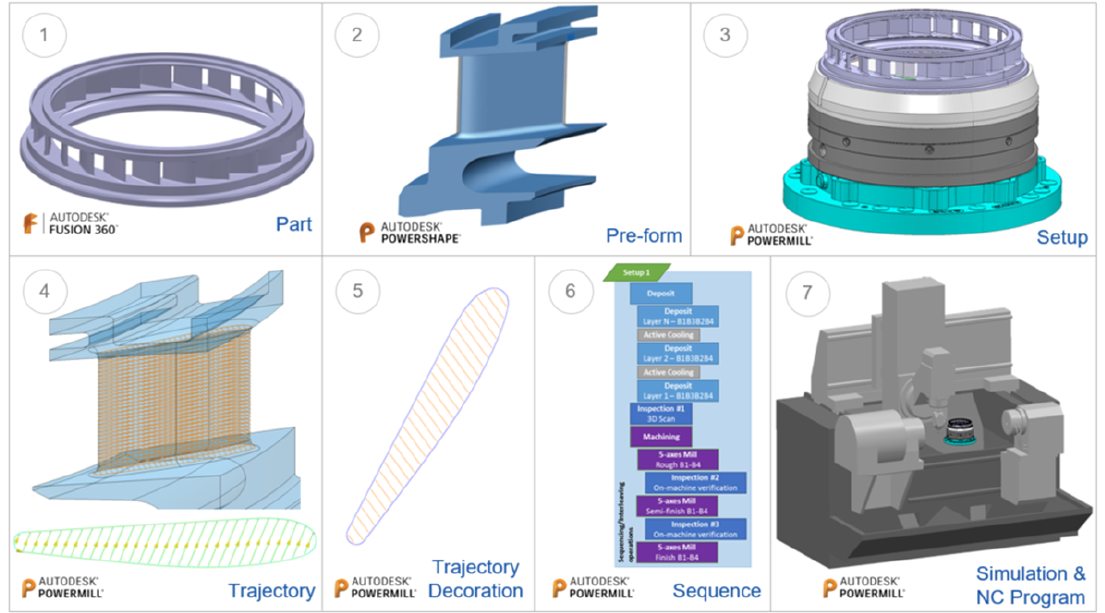
Figure 10. Complete CAx for Hybrid LMD